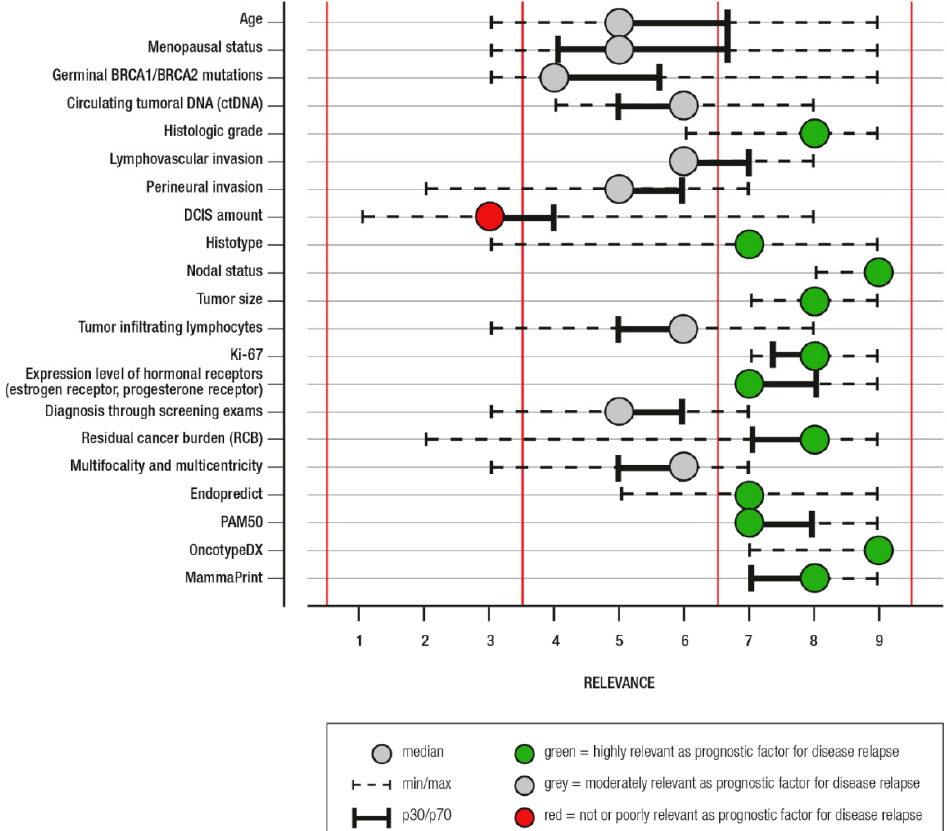
Figure 1. RAND results (2nd round): 1 = not relevant as prognostic factor for disease relapse; 2–3 = poorly relevant as prognostic factor for disease relapse; 4–6 = moderately relevant as prognostic factor for disease relapse; 7–9 = highly relevant as prognostic factor for disease